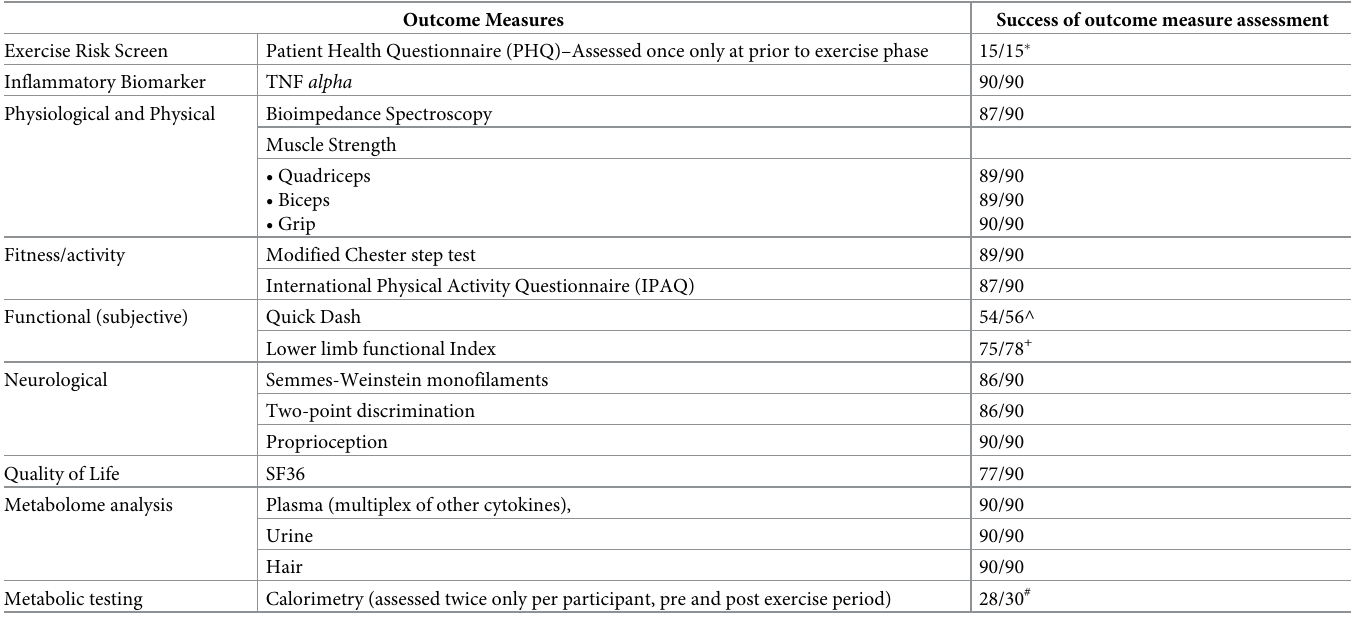
Table 2. Capture success rate of outcome measures: six assessment session per participant (n =